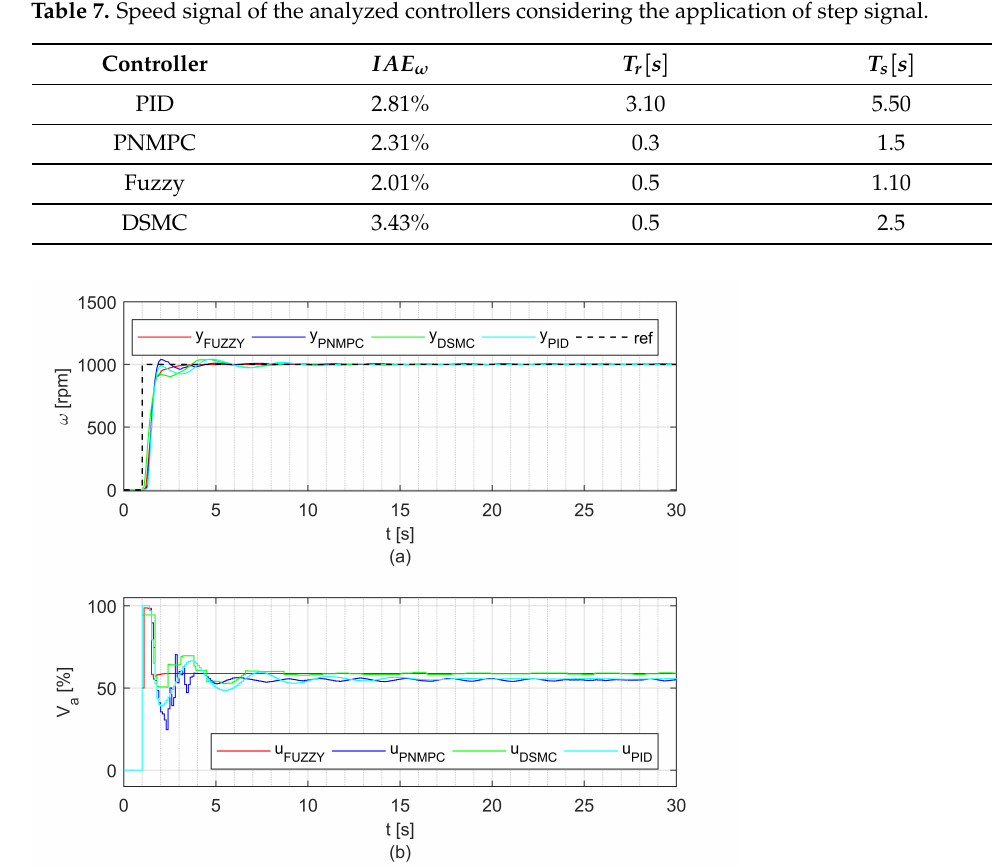
Figure 13. Output signal of the DC motor system in the test with application of step signal: ( a ) speed and ( b ) armature